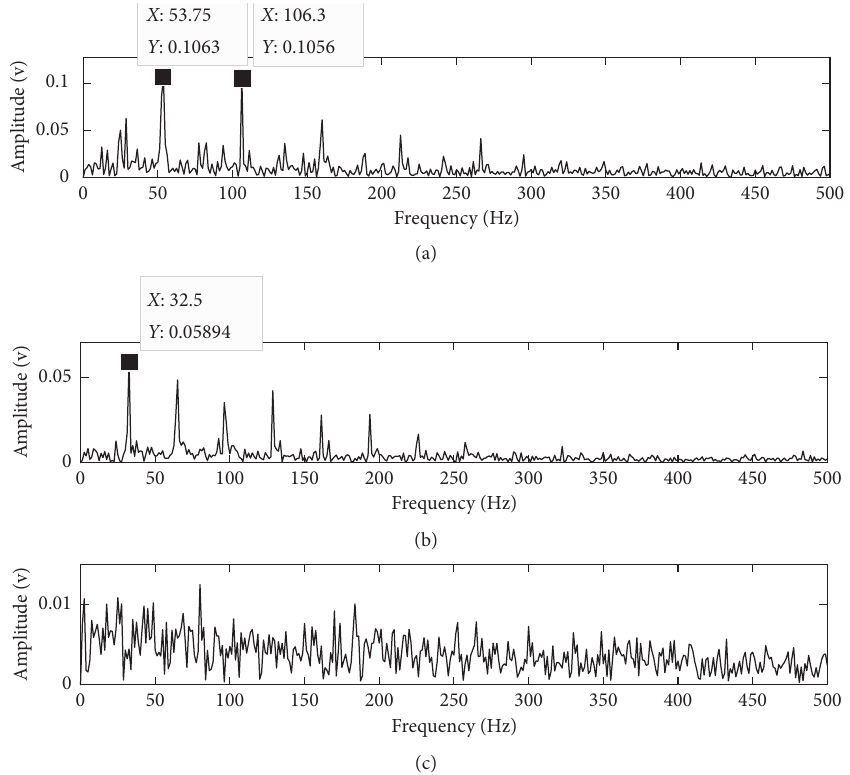
Figure 7: The envelope demodulation spectral analysis results of the signals as shown in Figure